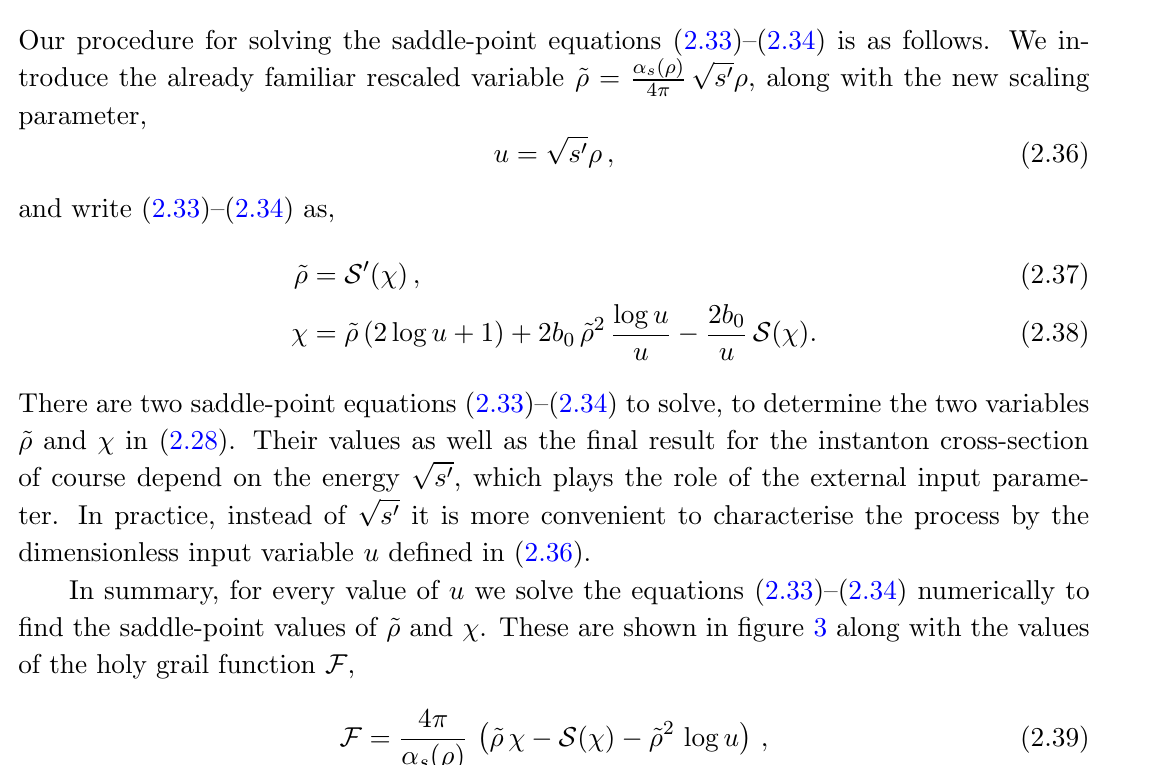
F and of the 4 (cid:25)